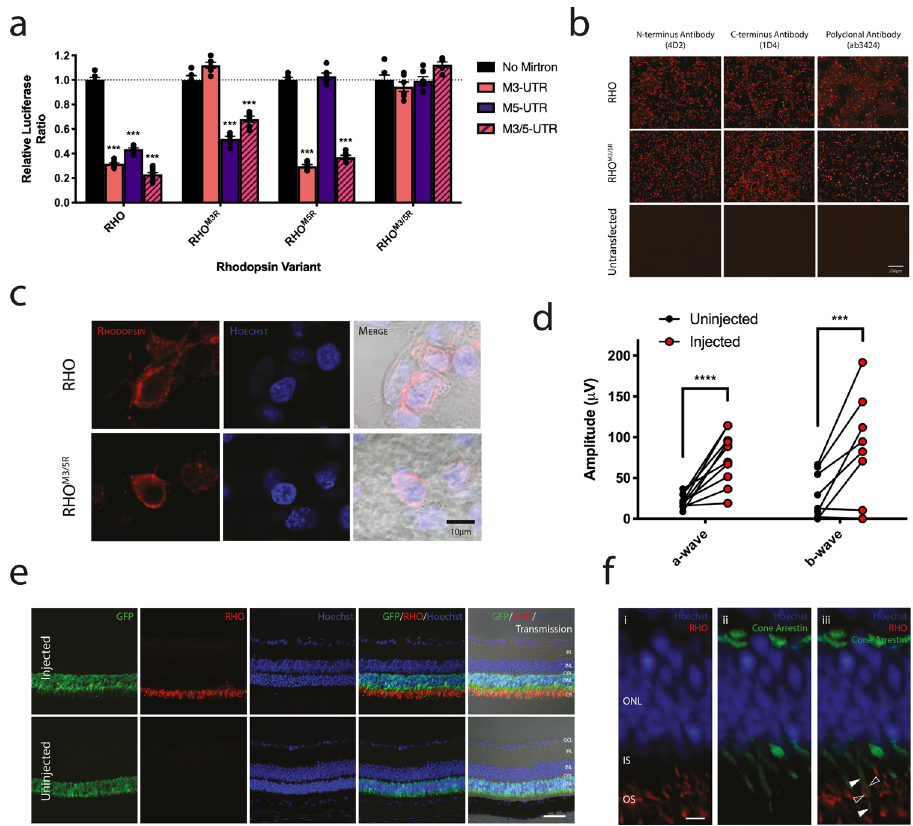
Fig. 3 Codon modi fi cation of human rhodopsin. a Dual Glo ® assays demonstrate codon-modi fi cation of target regions confers resistance to suppression by the corresponding mirtron(s). Mean ± SEM plotted, n = 6. **** p < 0.0001, two-sided Dunnett ’ s multiple comparisons test. RHO M3R : M3-resistant RHO ; RHO M5R : M5-resistant RHO ; RHO M3/5R : M3- and M5-resistant RHO . b Rhodopsin immunostaining of wild type RHO - and codon modi fi ed RHO M3/5R